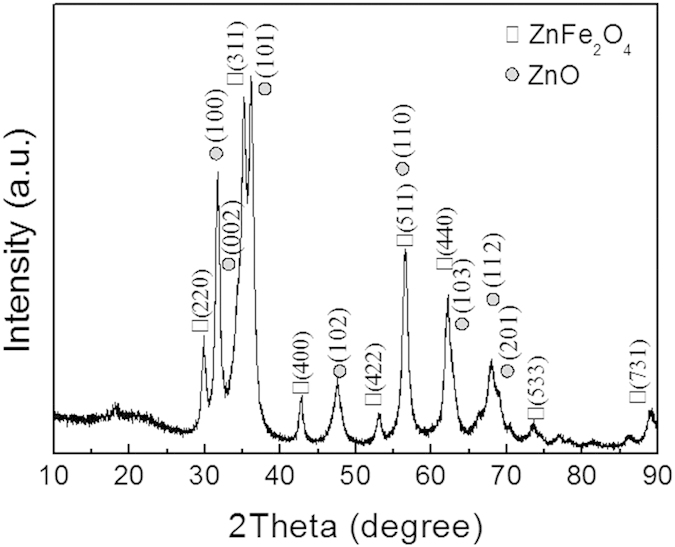
XRD pattern of the ZnO/ZnFe2O4 nanoparticles.